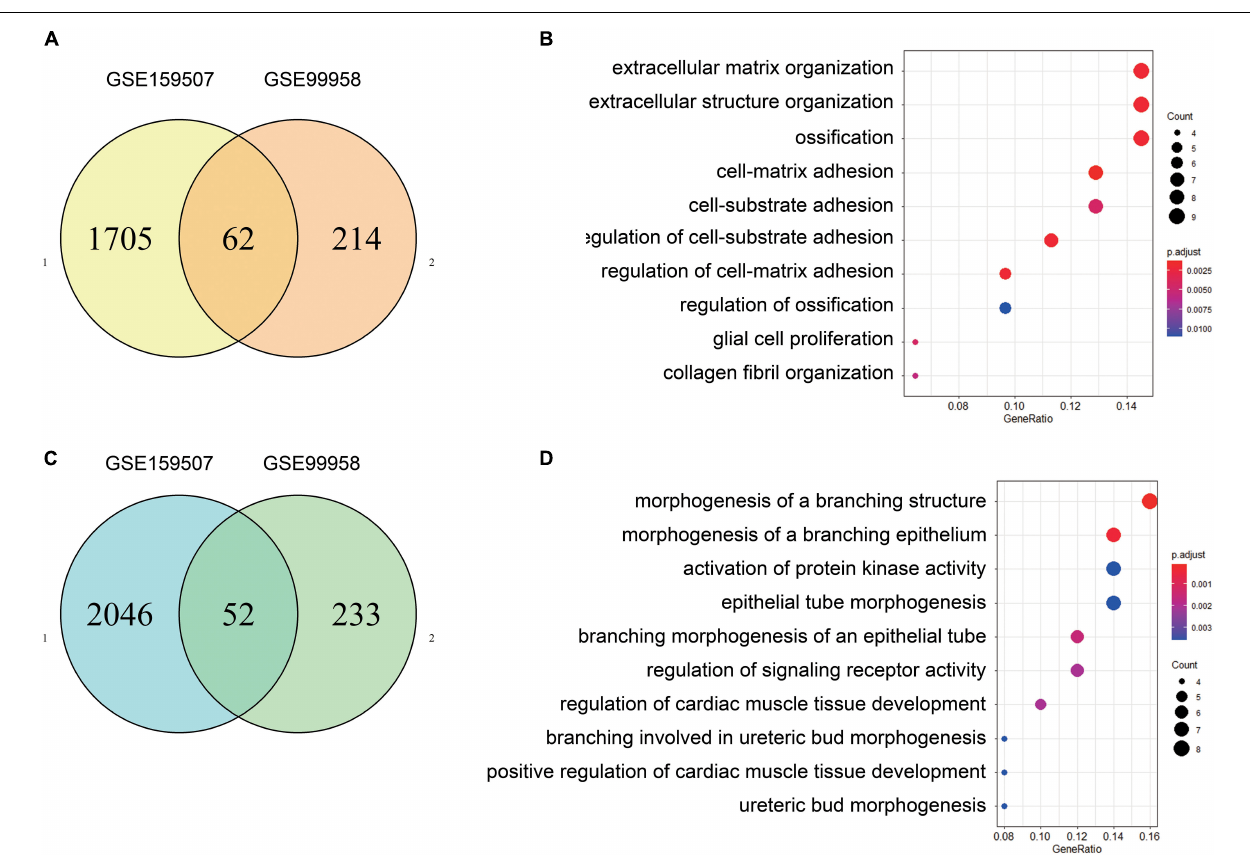
FIGURE 2 | Identification and GO enrichment analysis of common differentially expressed genes. After the common DEGs of GSE99958 and GSE159507 were determined, there were 62 up-regulated genes and 52 down-regulated genes (A,C) . Functional enrichment analysis shows biological processes (BP), cellular components (CC), and molecular functions (MF) enrichment from analyses of the 62 up-regulated genes (B) and 52 down-regulated genes (D) . P value is 0.05. The GO enrichment analysis of up-regulated genes is mainly concentrated in “extracellular matrix organization,” “extracellular structure organization,” and “ossification.” The GO enrichment of down-regulated expressed genes mainly includes “morphogenesis of a branching structure,” “morphogenesis of a branching epithelium,” and “activation of protein kinase activity.”